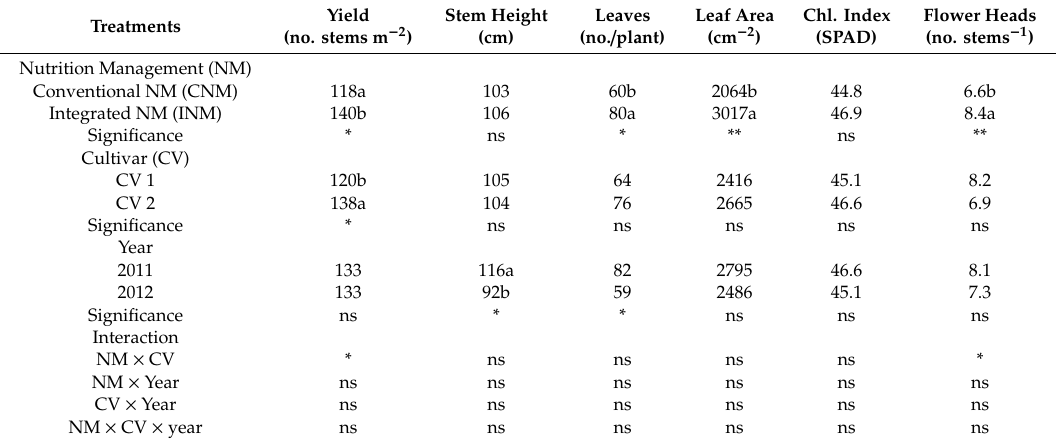
Table 3. Main e ff ects of nutrient management, cultivar on yield, stem height, leaf number, leaf area, chlorophyll index, and number of flower heads in chrysanthemum plants over the two years of application. Yield Stem Height Leaves Leaf Area Chl. Index Flower Heads Treatments (no. stems m − 2 ) (cm) (no. / plant) (cm − 2 ) (SPAD) (no. stems − 1